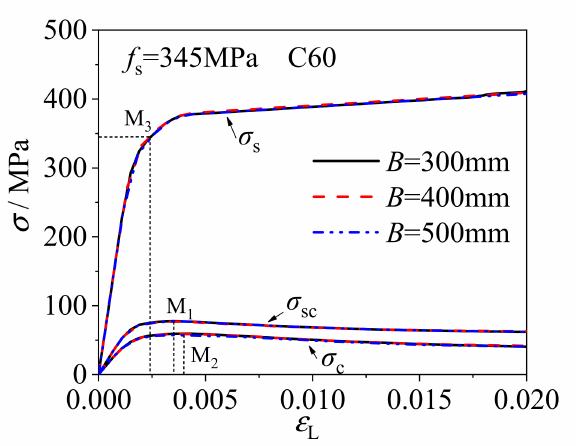
Figure 7. The influence of B on the mechanical performance of square CFCFST stub columns ( B / t = constant).